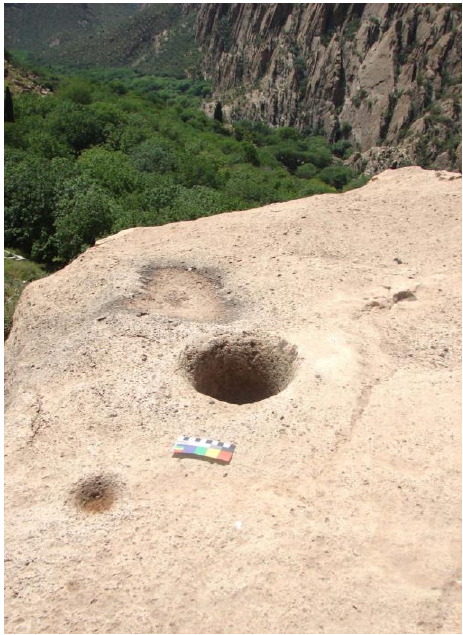
Figure 10. Mortars and cupules in the rock art of Ryjab village.